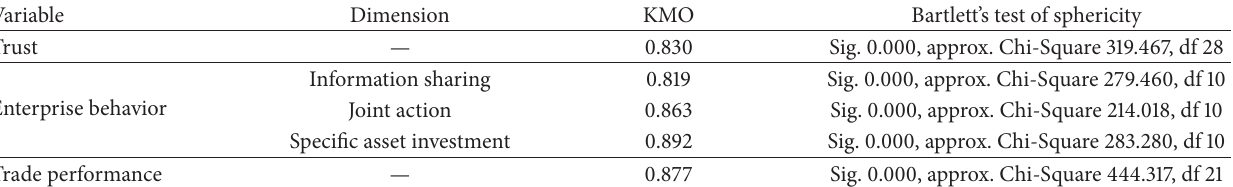
Table 10: The KMO and Bartlett’s test of sphericity.